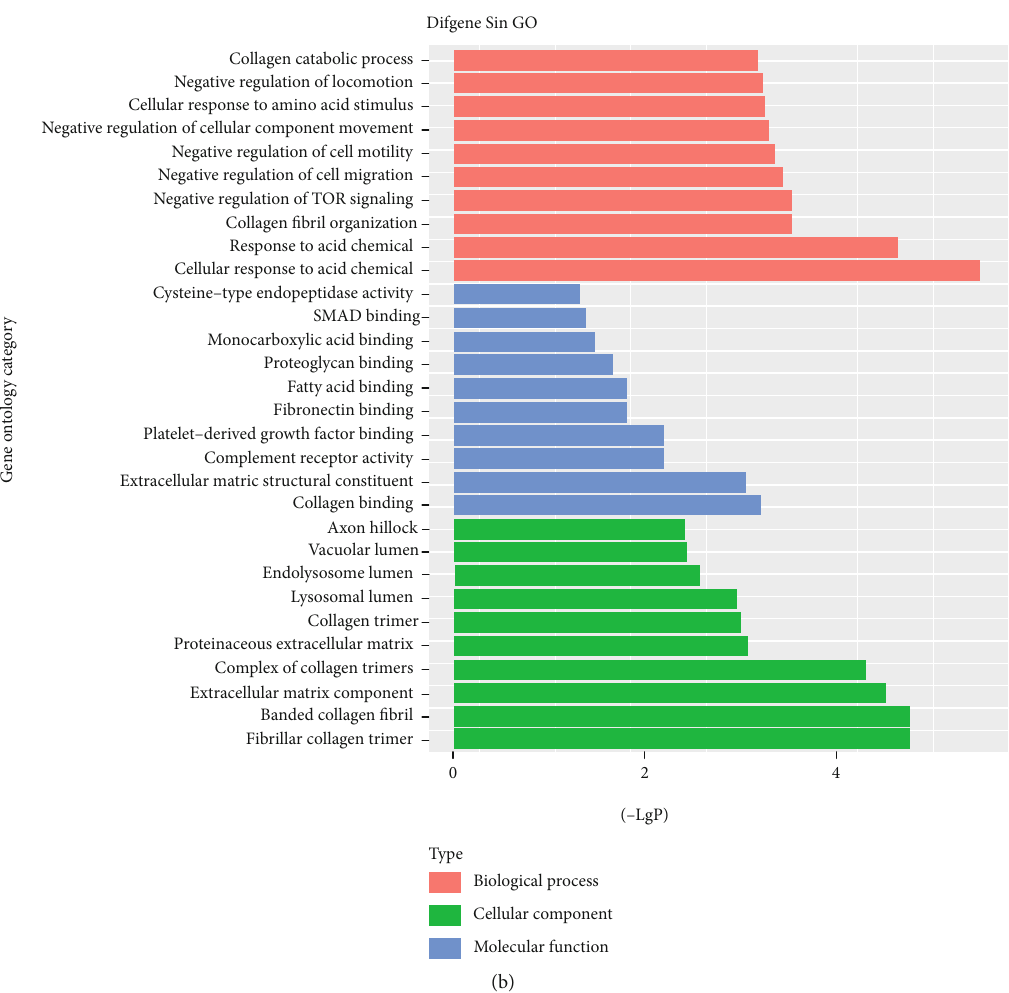
Figure 4: Signi fi cant gene ontology (GO) analyses of di ff erentially expressed genes in KDM3B overexpression SCAPs compared with the control group. (a) The signi fi cant GO functions of upregulated genes during KDM3B overexpression. (b) The signi fi cant GO functions of downregulated genes during KDM3B overexpression. The y -axis represents the GO category, and the x -axis represents the negative logarithm of the P value ( − LgP). A larger − LgP indicated a smaller P value for the di ff